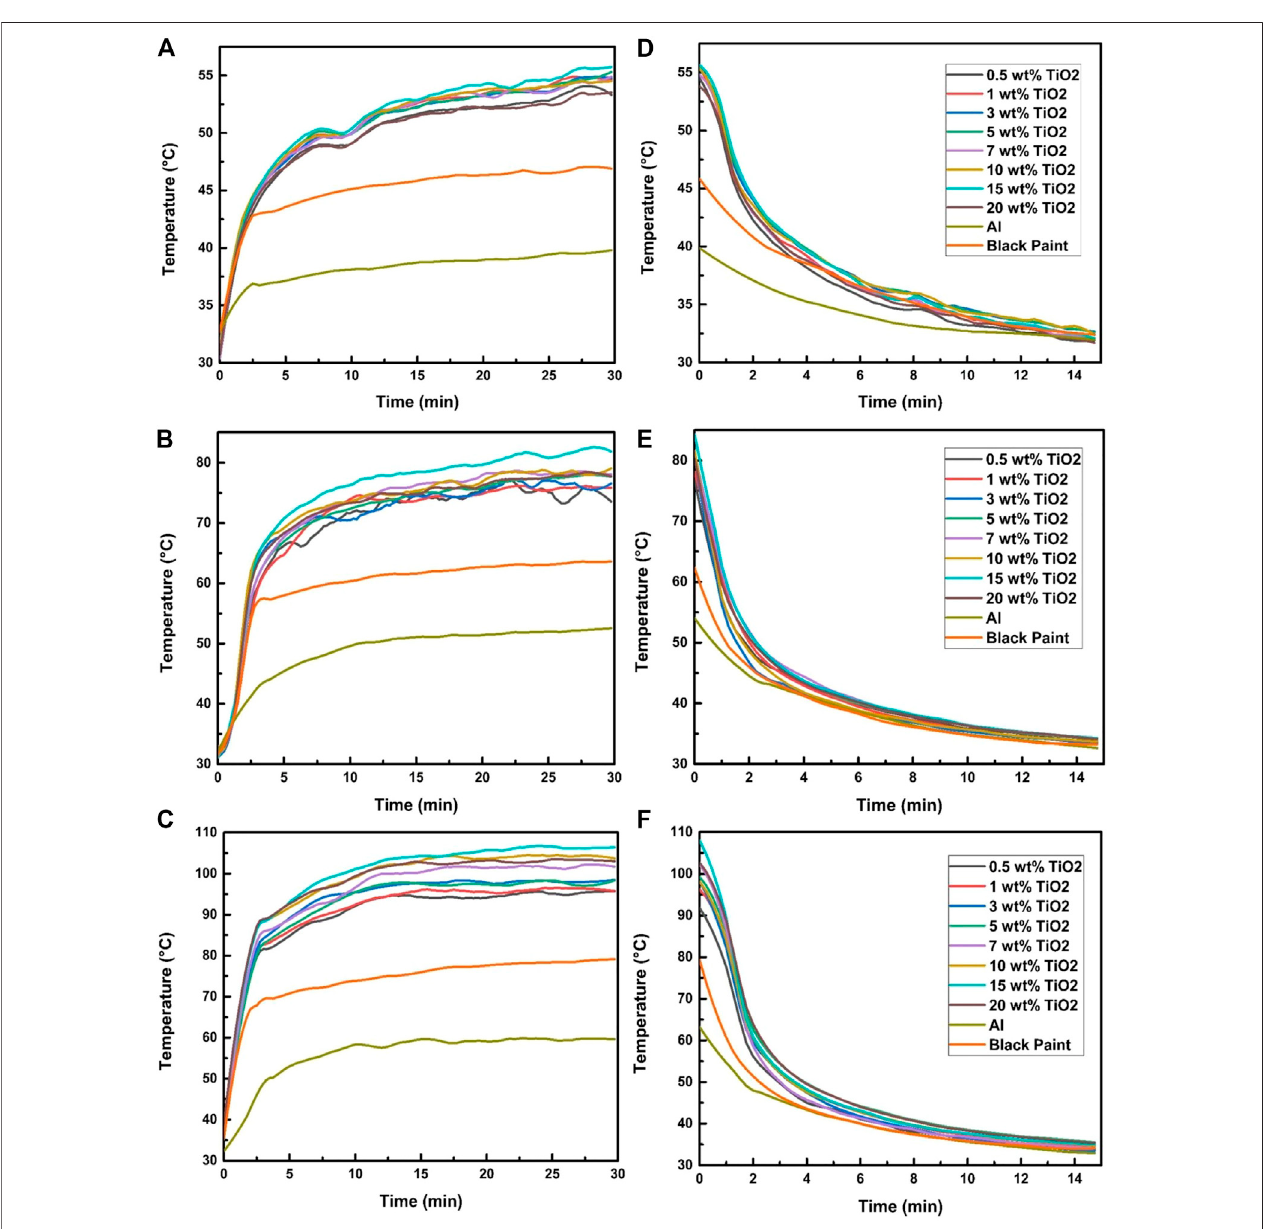
FIGURE4| EffectofTiO 2 -20 nmontheabsorbertemperatureatirradiationexposureof (A) 200 W/m 2 , (B) 600 W/m 2 ,and (C) 1,000 W/m 2 and (D – F) temperature drop pro fi le.